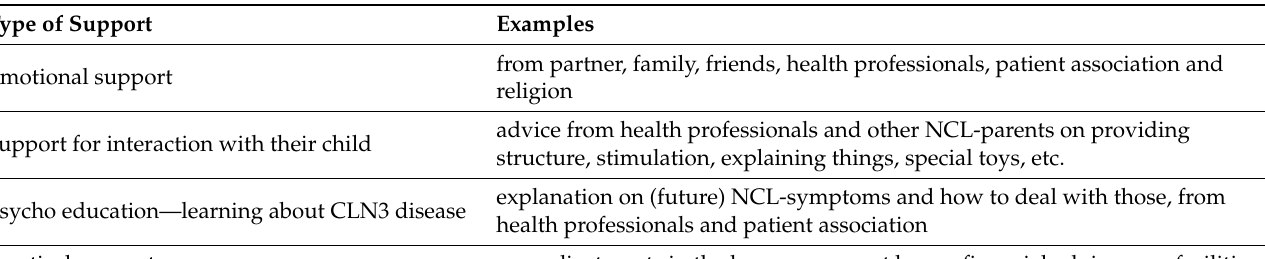
Table 3. Observed support for parents.